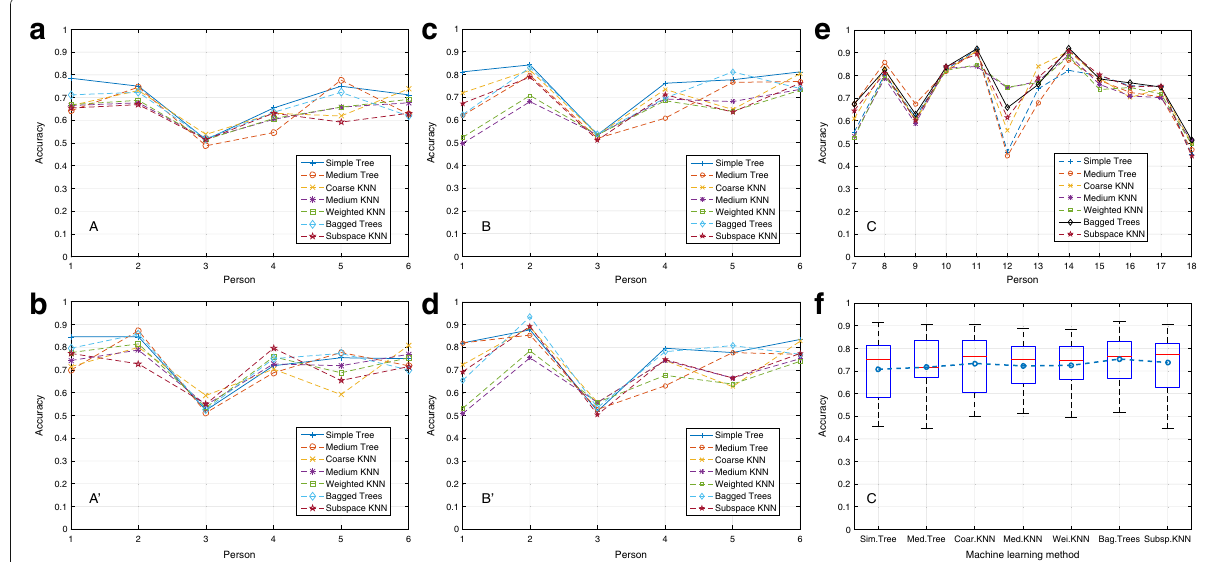
Fig. 6 Results on accuracy of attention prediction. Attention estimation accuracies of seven classifiers are shown for each test subject on datasets: a A (normalized features), b A’ (normalized with post-filtering), c B (normalized and smoothed features), d B’ (with post-filtering), and e C (normalized and smoothed features). Graph f represents distributions (shown as boxes) and average accuracies of each classifier over all test subjects of dataset